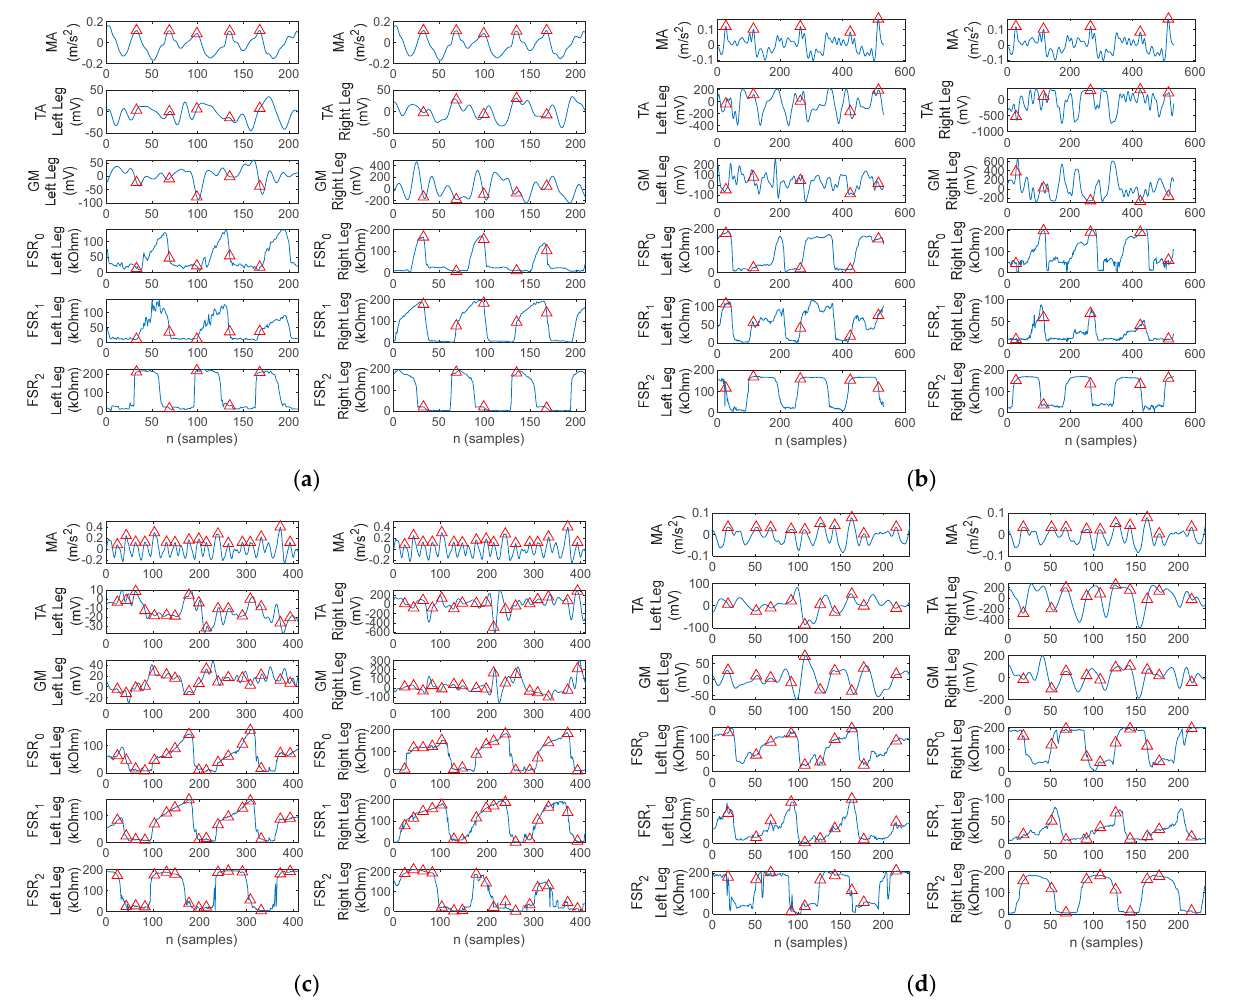
Figure 13. Three-cycle gait section plot of the arm balance MA, bilateral EMG of the TA and GM, and FSR signals, with the red triangles indicating the MA maxima, acquired with the proposed physiograph during walking trials on ( a ) healthy control, ( b ) PD Patient 5, ( c ) PD Patient 1, and ( d ) PD Patient 3.